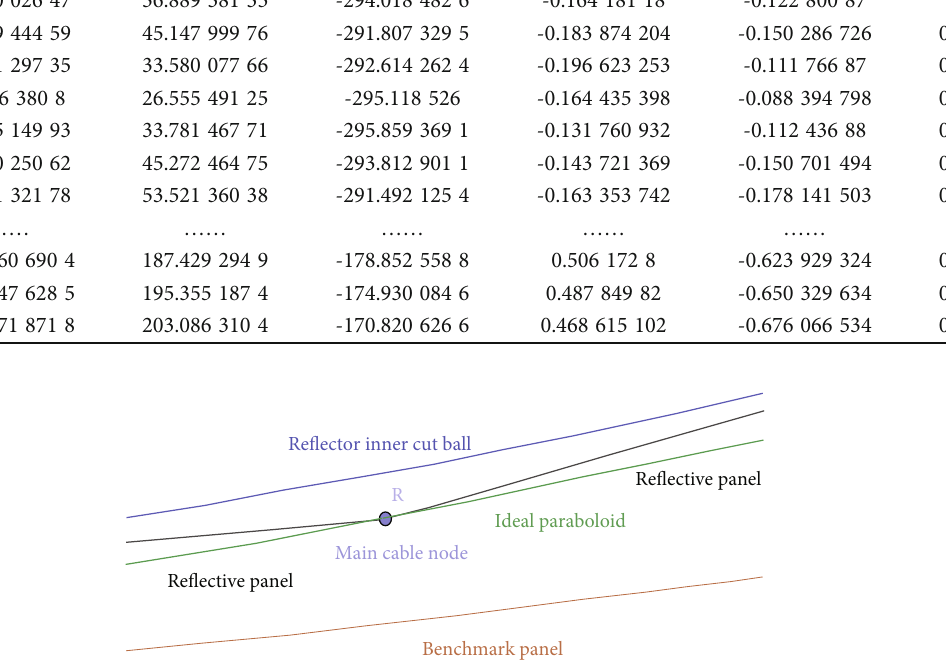
Figure 2: Schematic diagram of ideal paraboloid, benchmark sphere, and inscribed sphere of re fl ector.